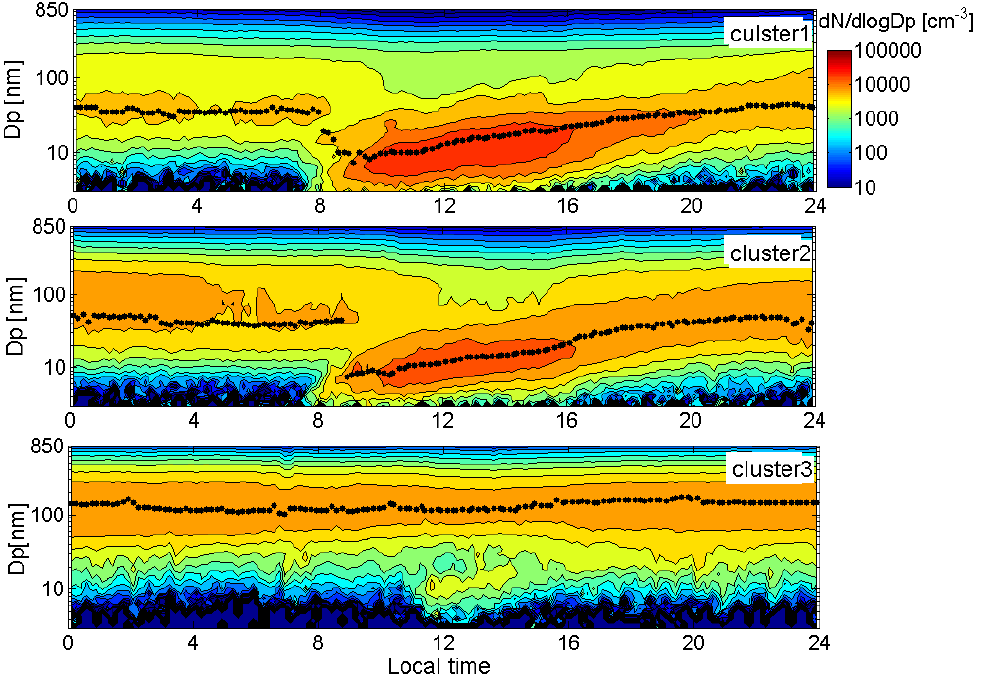
Fig. 5. Mean diurnal evolution of the particle number size distributions, averaged over the three trajectory clusters. Black dots indicate the geometric mean diameter of the dominating mode.